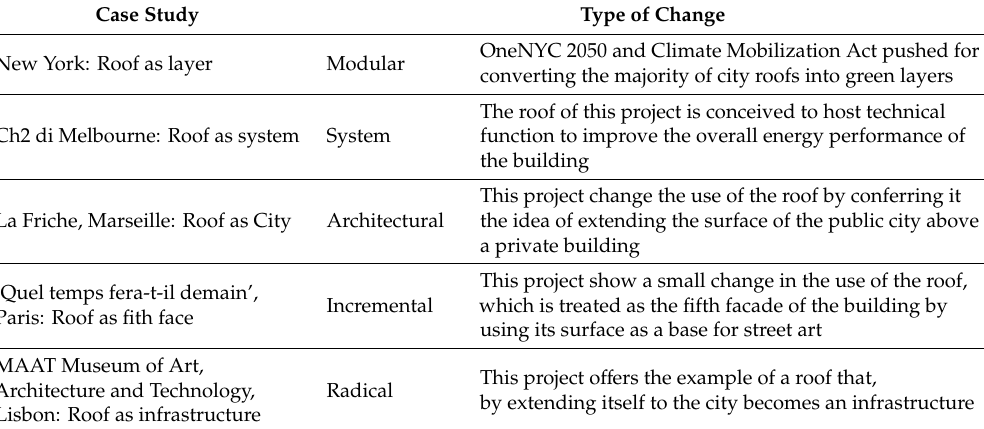
Table 1. Criteria to assess rooftop renovation